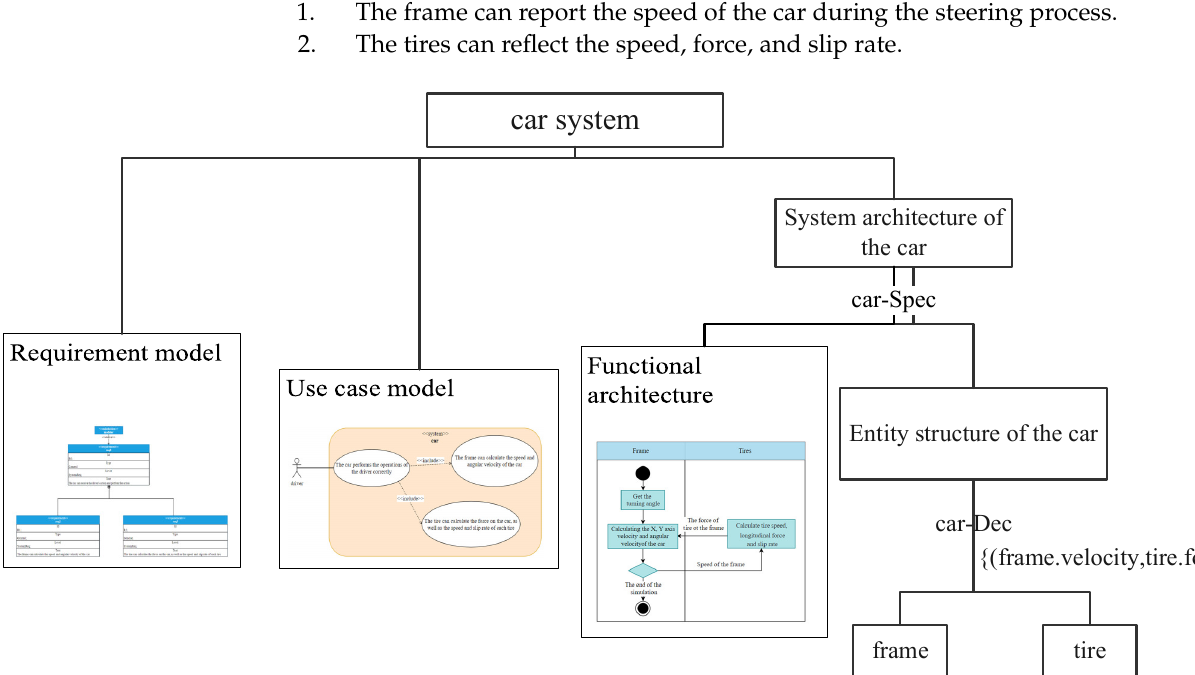
Figure 8. The Analysis Model of A Car in SES-X.